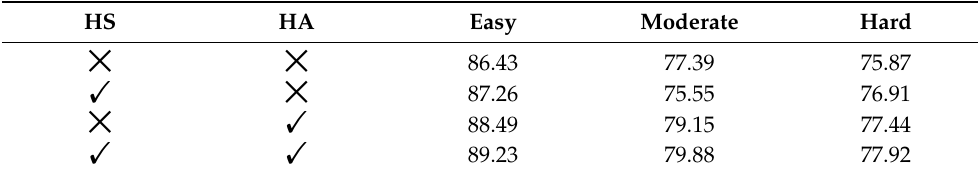
Table 4. Ablation experiments on the effect of the HS and HA modules.